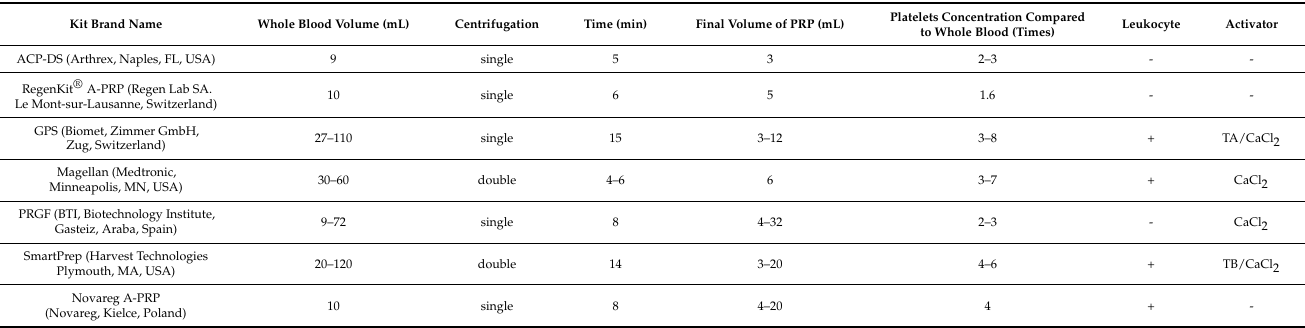
Table 2. Specification of different PRP